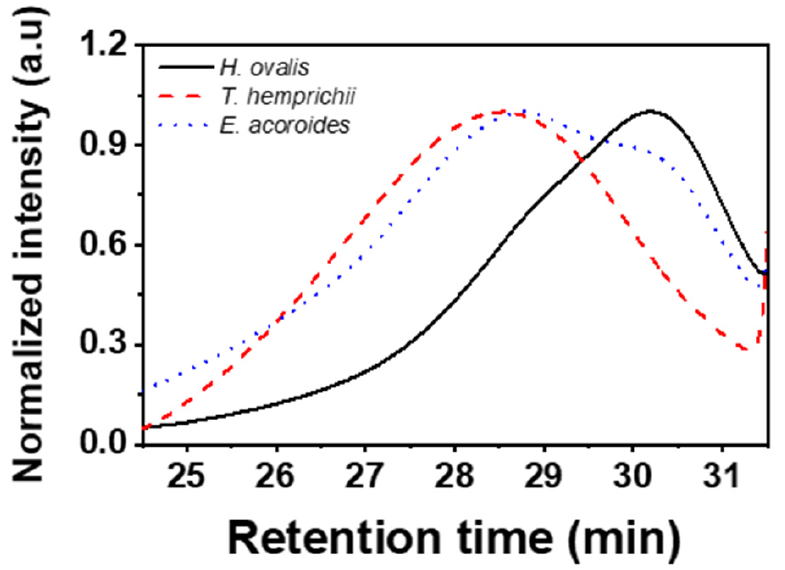
Figure 3. GPC curves of Vietnamese seagrass pectin. Table 1. Summary of the physicochemical characterization of pectins extracted from the examined Vietnamese seagrasses. Pectin